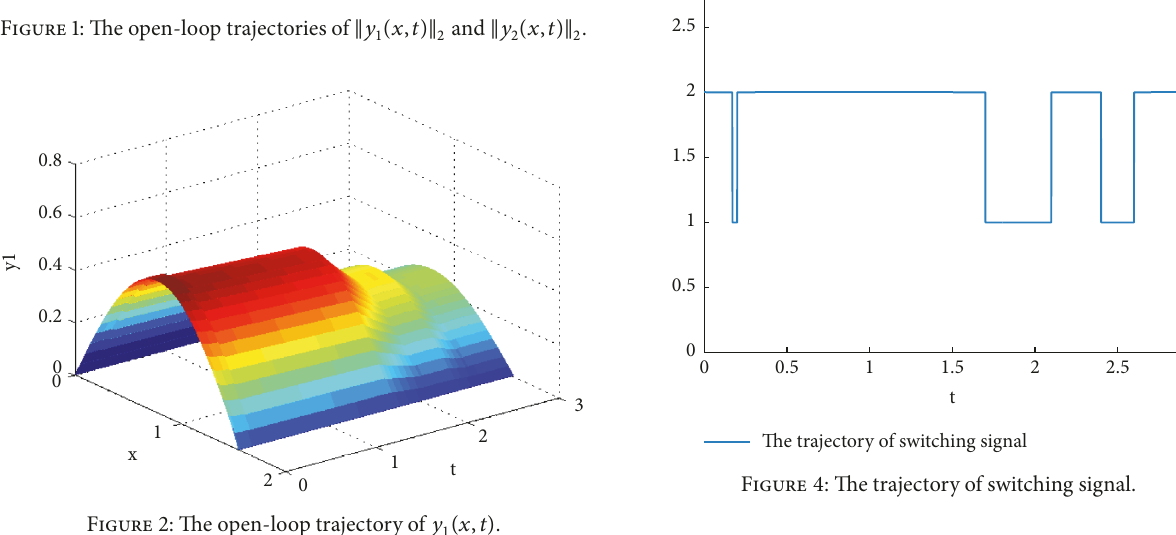
Figure 2: The open-loop trajectory of 𝑦 1 (𝑥,𝑡) .